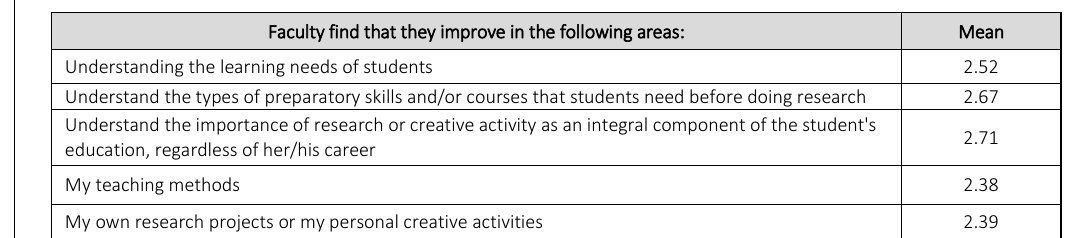
Table 3: Faculty ratings for benefits for them by engaging in RCA Faculty find that they improve in the following